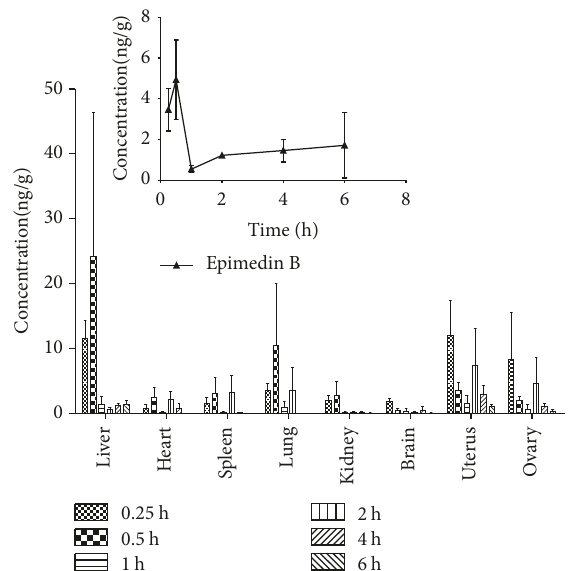
Figure 4: Mean plasma concentration-time profile and tissue distribution of epimedin B in female rats after a single oral dose of Herba Epimedii extract (containing 15 mg/g epimedin